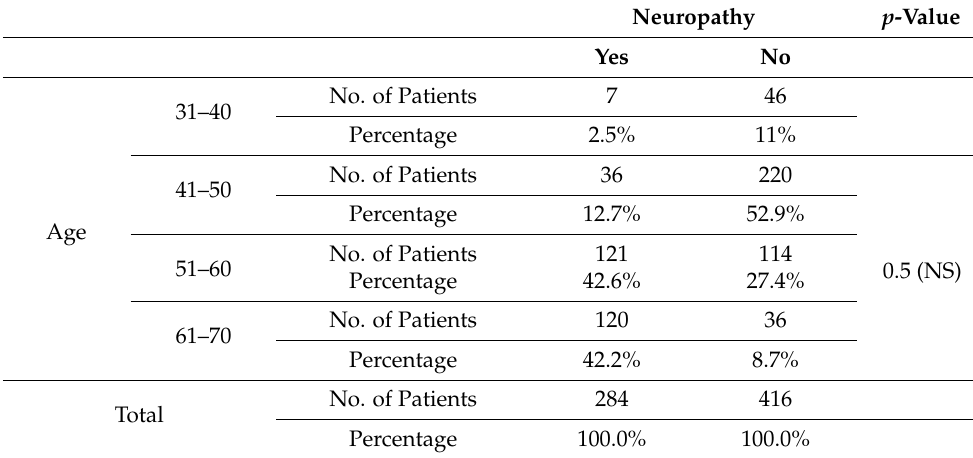
Table 5. Prevalence of clinical neuropathy in different age groups.